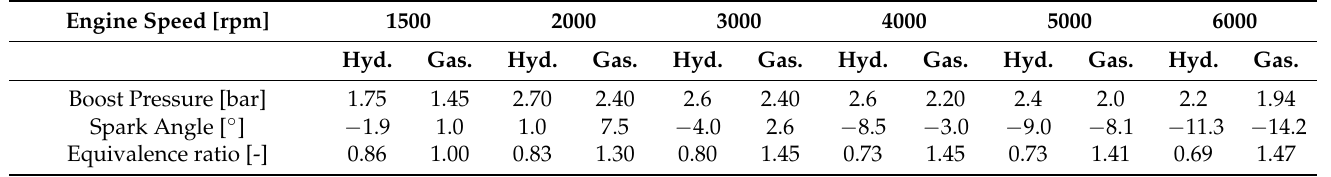
Table 4. Main engine operating parameters at full load.